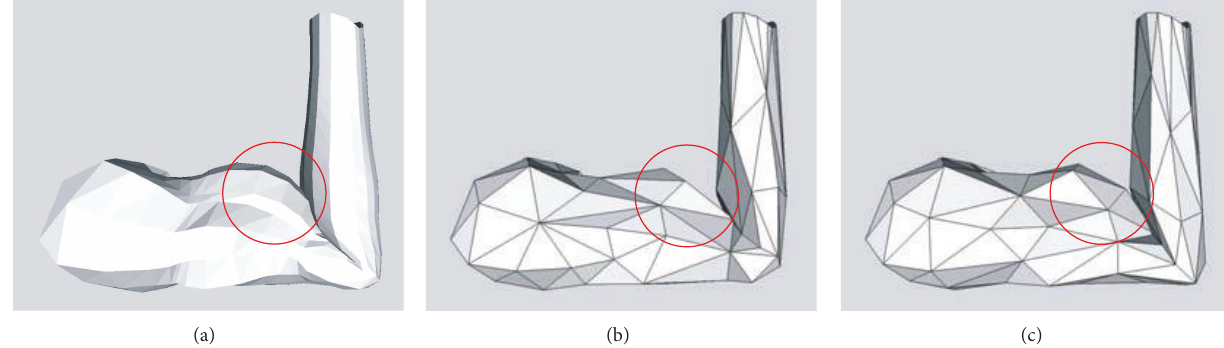
Figure 1: Simplification results between the single-pose QEM and the DSD method. (a) Original model; (b) simplifying by single-pose QEM; (c) the DSD method [22].